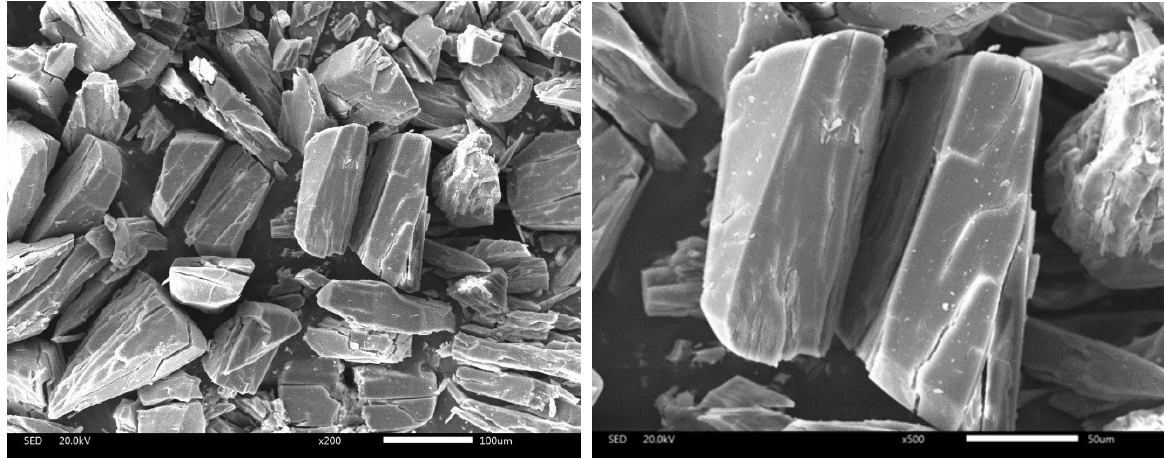
Figure 10. SEM Analysis of CdMOF at different resolutions.